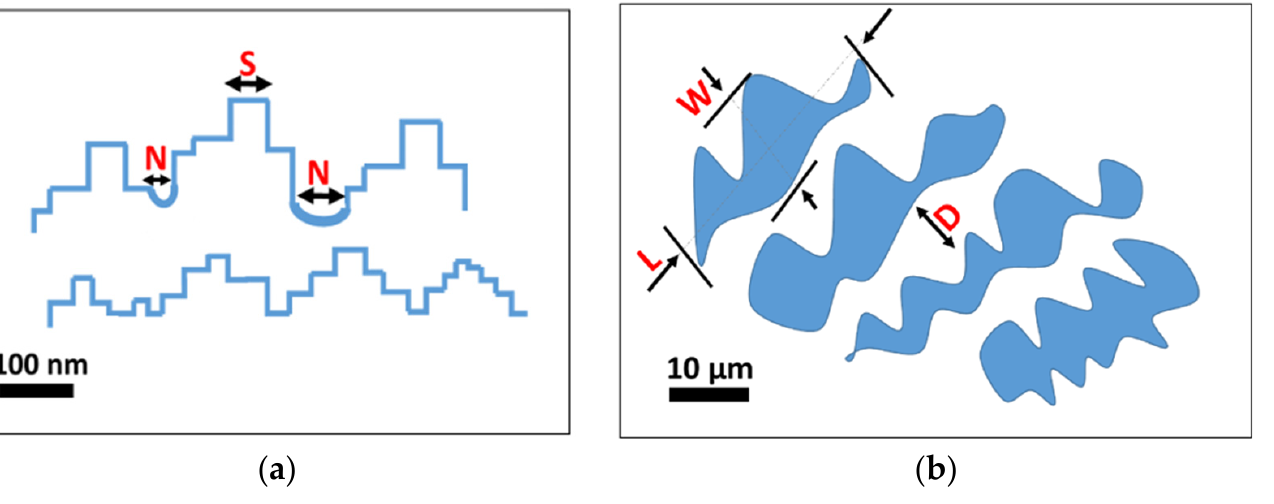
Figure 3. Schematic representation of the super-hydrophobic surface structures ( a ) geometrical parameters for nano-scale morphological characterization; ( b ) geometrical parameters for micro-scale morphological characterization.